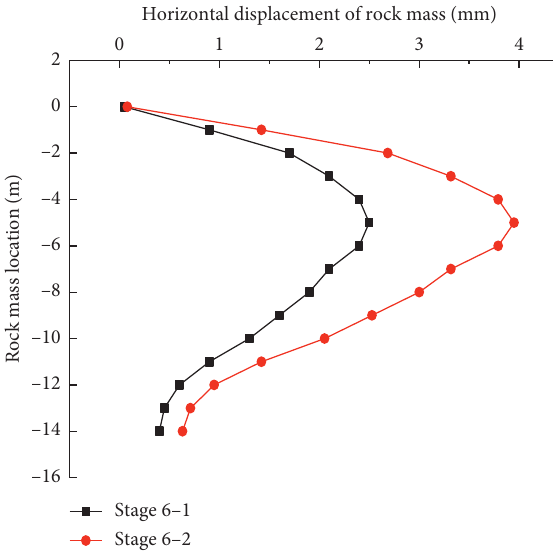
Figure 15: Horizontal displacement of rock mass.